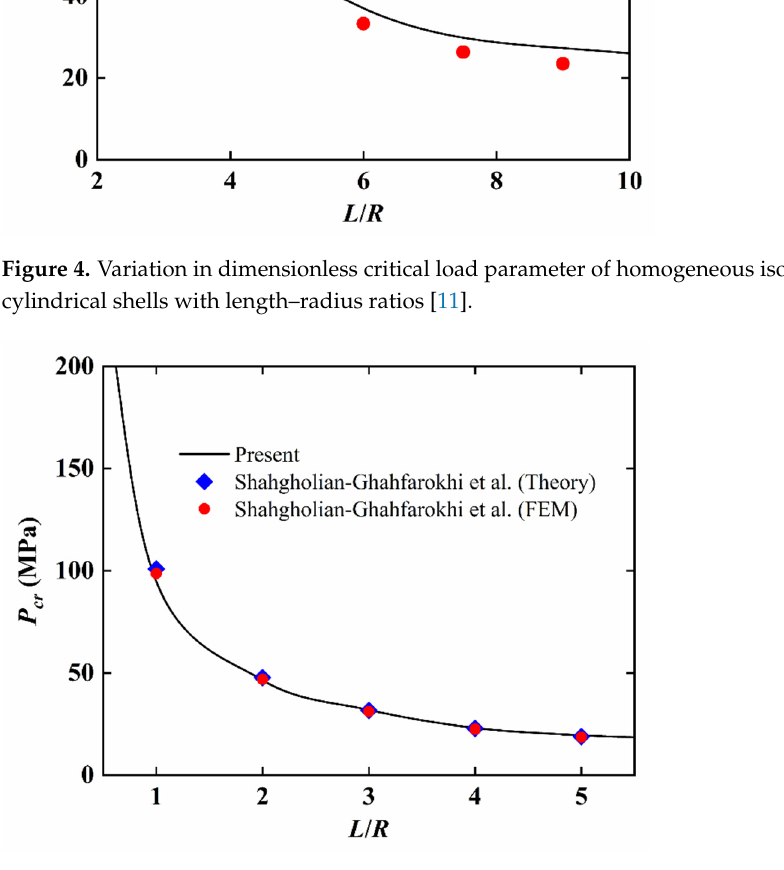
Figure 5. Variation in critical pressure of unstiffened nonporous GPLRC cylindrical shells with length–radius ratios [36].